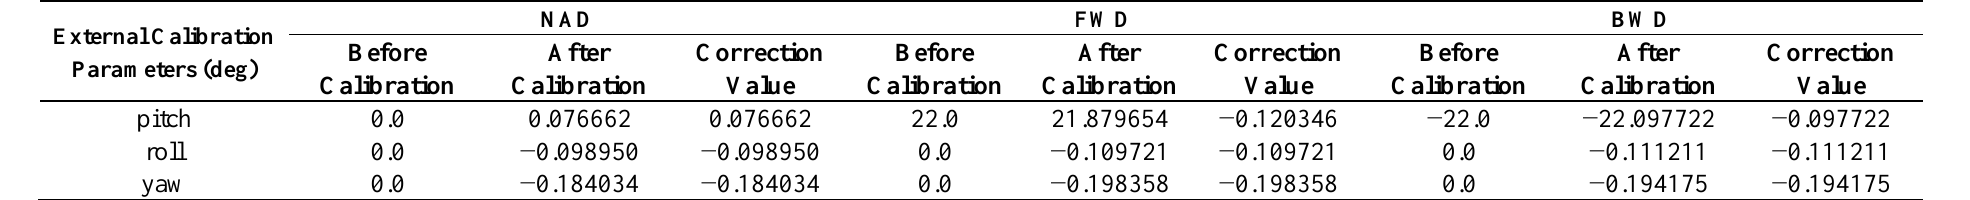
Table 5. External calibration parameter values before and after calibration of ZY-3 three-line array